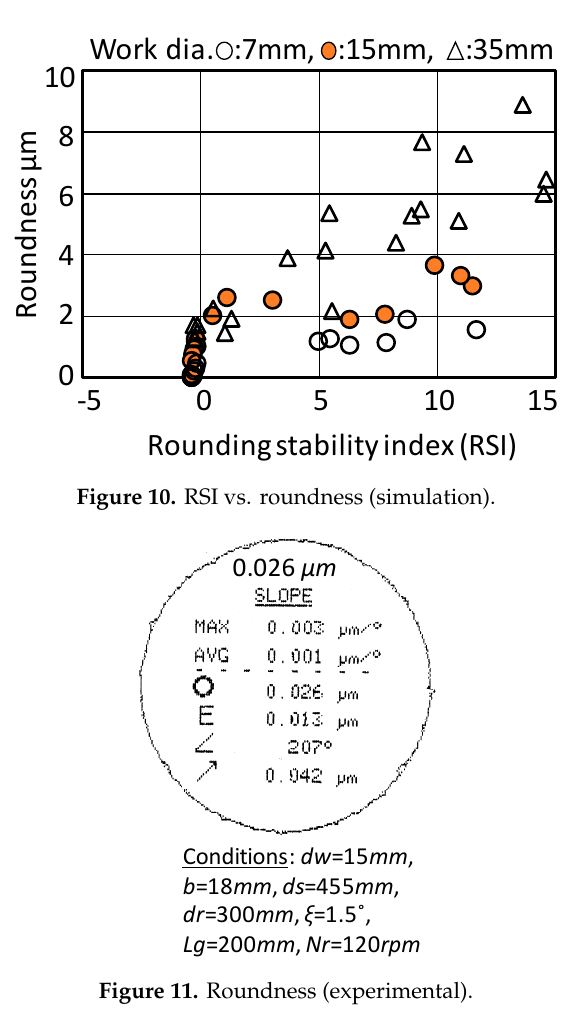
Figure 11. Roundness (experimental).